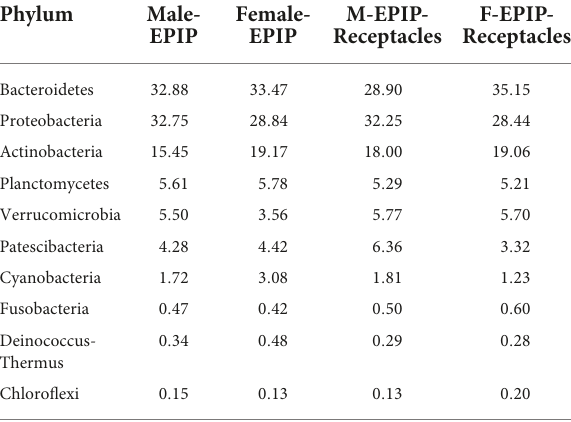
TABLE 4 The top 10 of relative abundances of epiphytic bacteria on algal bodies and receptacles of male and female S. thunbergii at the genus level (%).